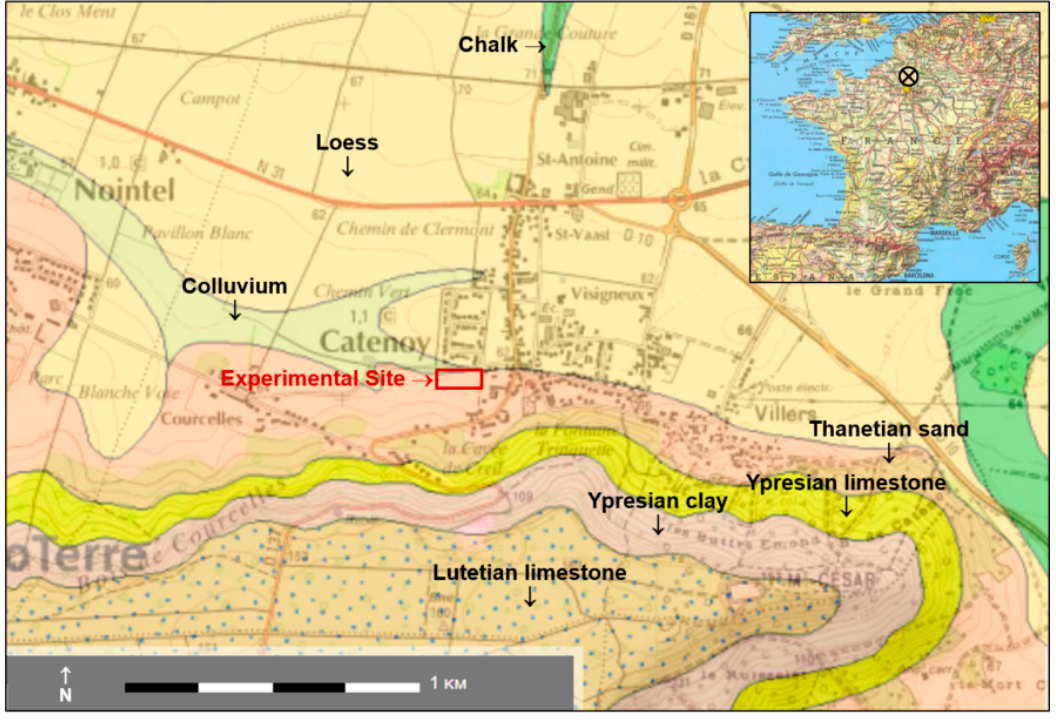
Figure 1. Location and geological context of the experimental site.